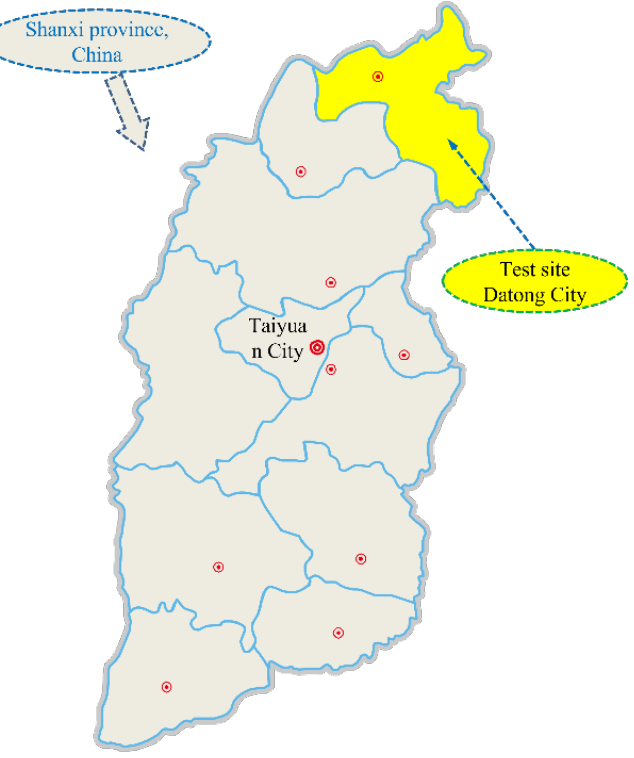
Figure 2. Location of the Project.